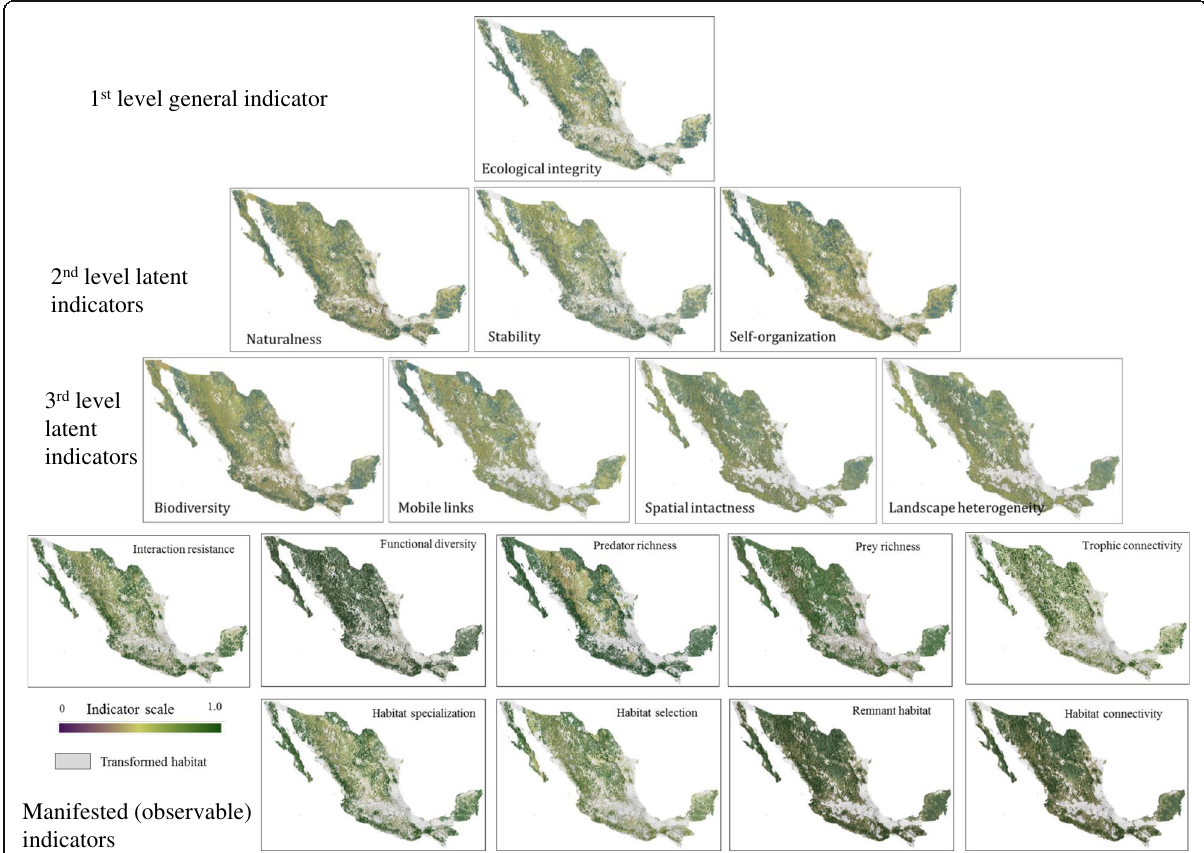
Fig. 2 The ecological indicator hierarchy network (EIHN) for evaluating the status of remnant landscapes for apex predators and their